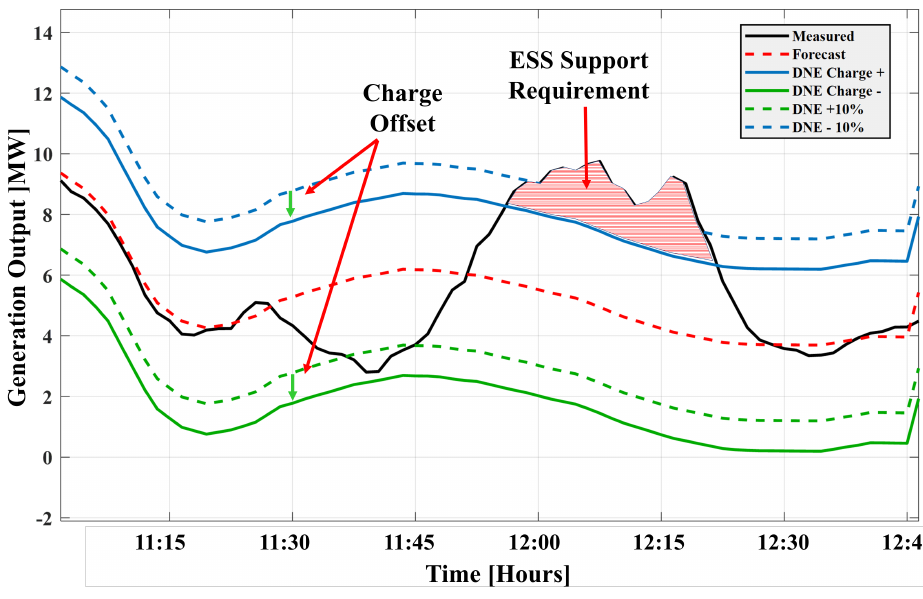
Figure 5. Operation of a dispatchable substation in the charge mode.